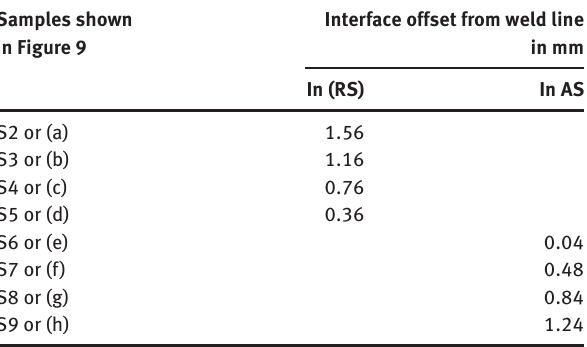
Table 1: Interface offset positions for various samples cut along the weld line shown in Figures 5 and 8.